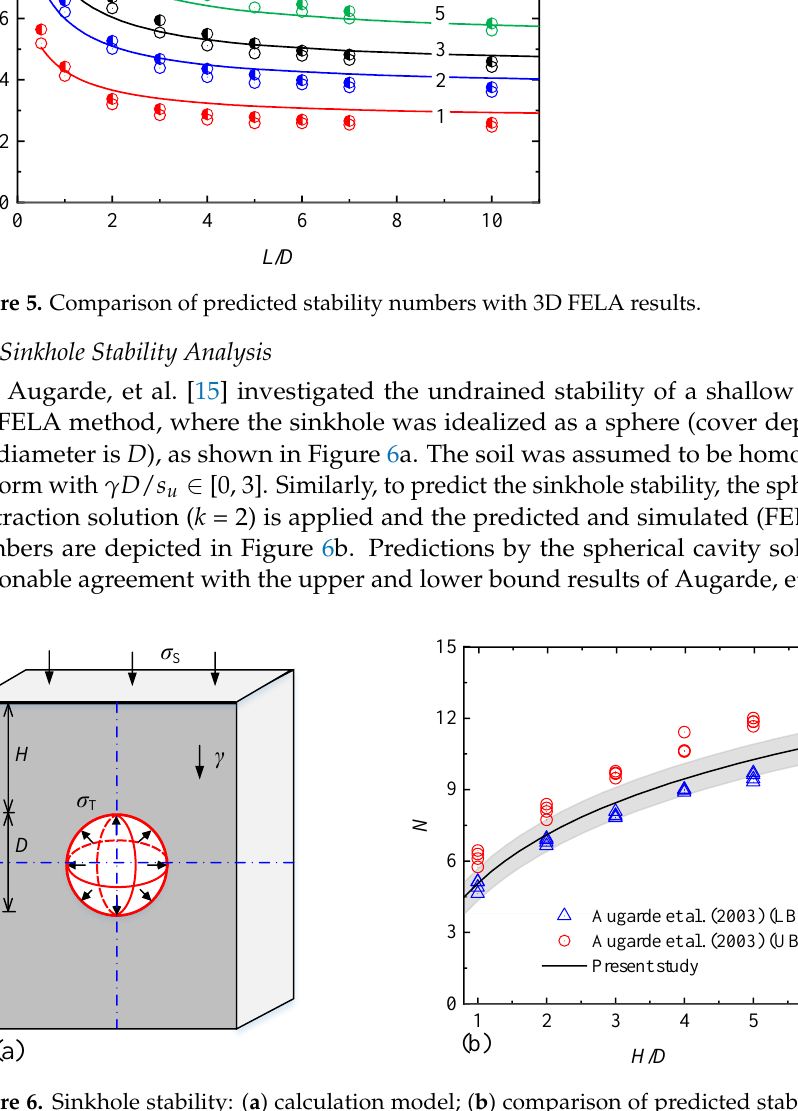
Table 1. Database of the tunnel/sinkhole stability number ( L / D ≥ 0.5).